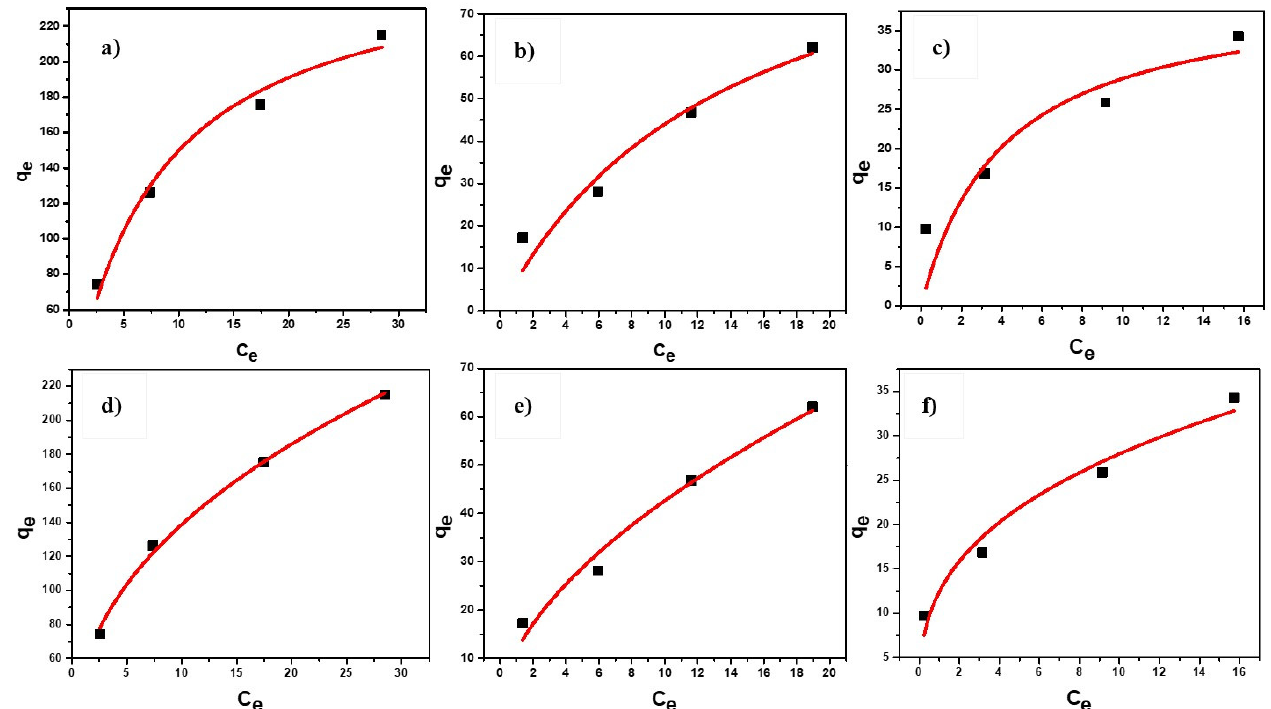
Figure 7. Linear models of ( a ) Langmuir adsorption isotherm at 0.1, 0.5 and 1.0 g/L adsorbent dosages, ( b ) Freundlich